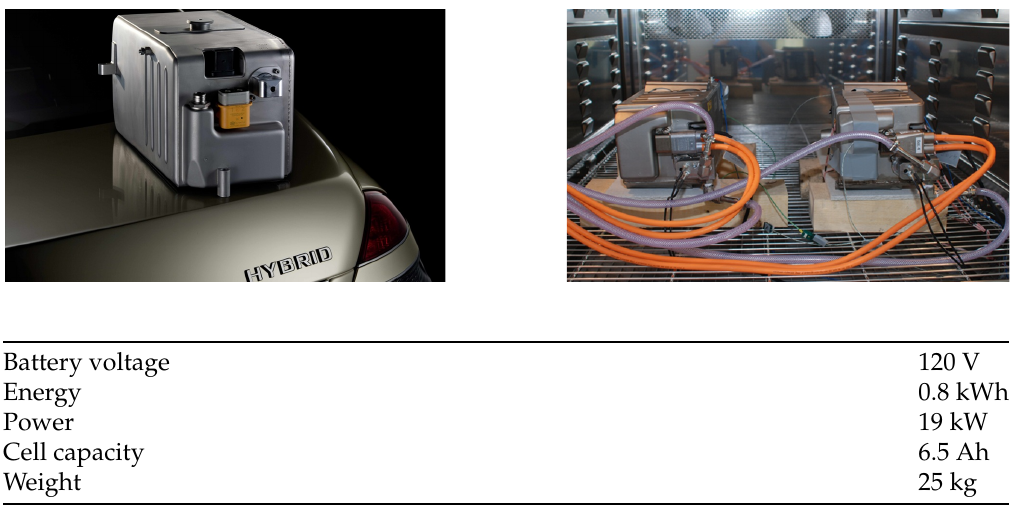
Figure 5. The Mercedes-Benz S400 Hybrid battery from [22] with its main specification [20]. The right picture shows the same battery type in a durability